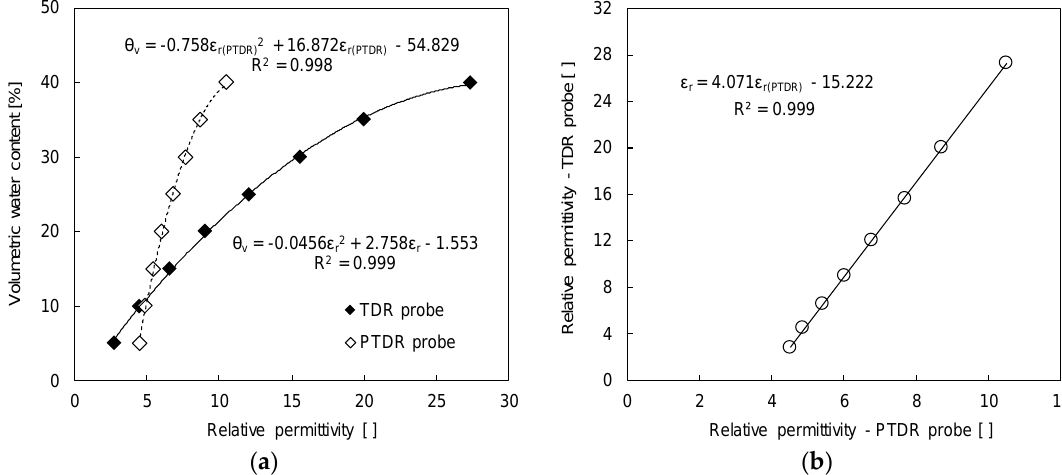
Figure 6. Calibration result: ( a ) Volumetric water content and the relative permittivity; ( b ) Relative permittivity measured using the TDR and TDCP probes.